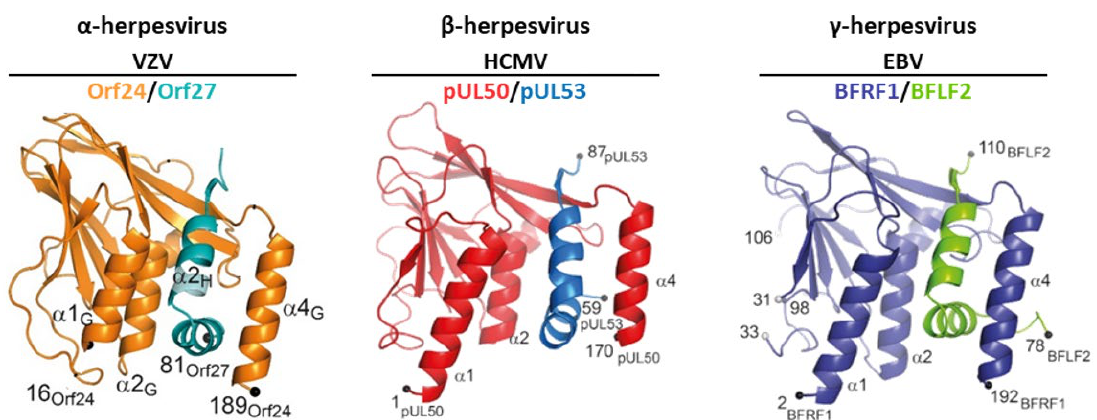
Figure 5. Structural conservation of the VZV, HCMV and EBV core NECs. Comparison of currently available 3D core NEC crystal structures of VZV, HCMV and EBV showing the hook-into-groove binding interface; modified from [32,70] .